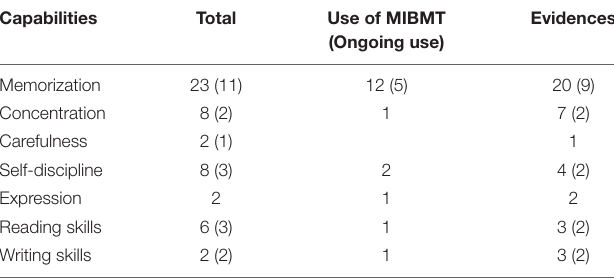
TABLE 16 | Theme 1: positive feedbacks after training in Experiment 2: improvement of capabilities (the numbers in parentheses represent high-use